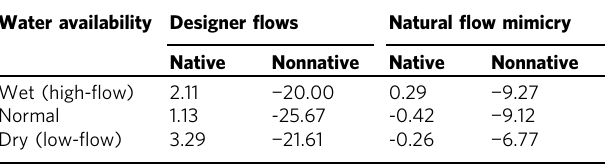
Table 1 Predicted average native and nonnative abundance gains and